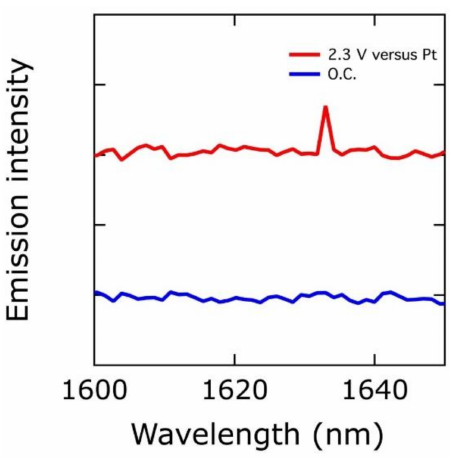
Figure 2. In red: near-IR luminescence spectrum (applied potential, 2.3 V vs. Pt) of [NiFe]-LDH. In blue: reference spectrum of the material taken at the open circuit potential